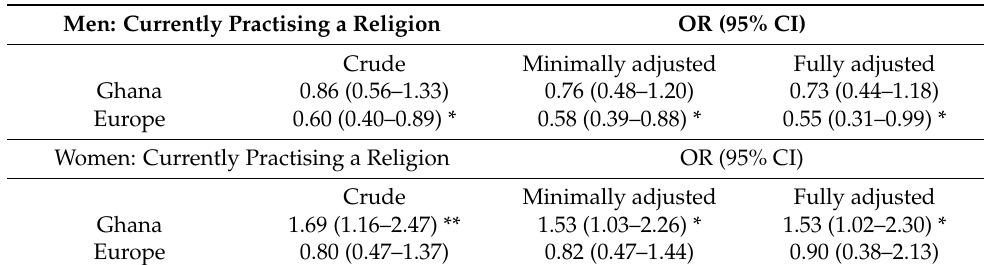
Table 3. Odds ratios for estimated elevated ( ≥ 7.5%) 10-year CVD risk in those practising a religion compared with not practising a religion, stratified by sex and site.